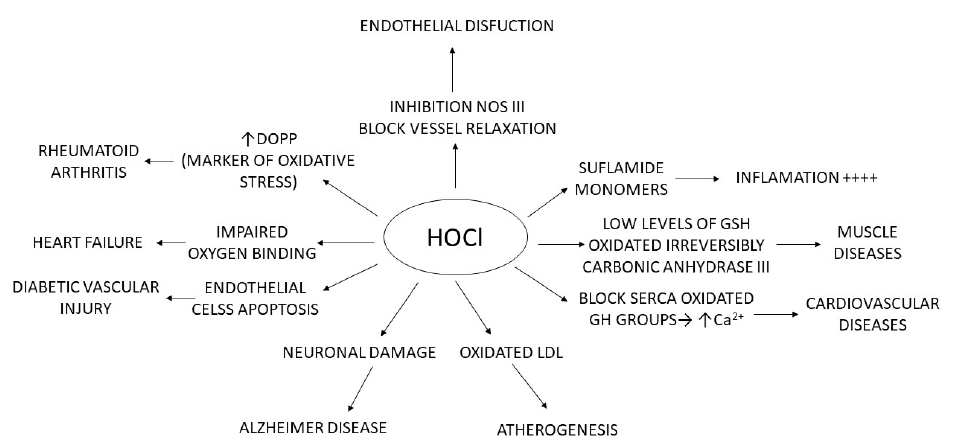
Figure 51. Relationship of HOCl with different